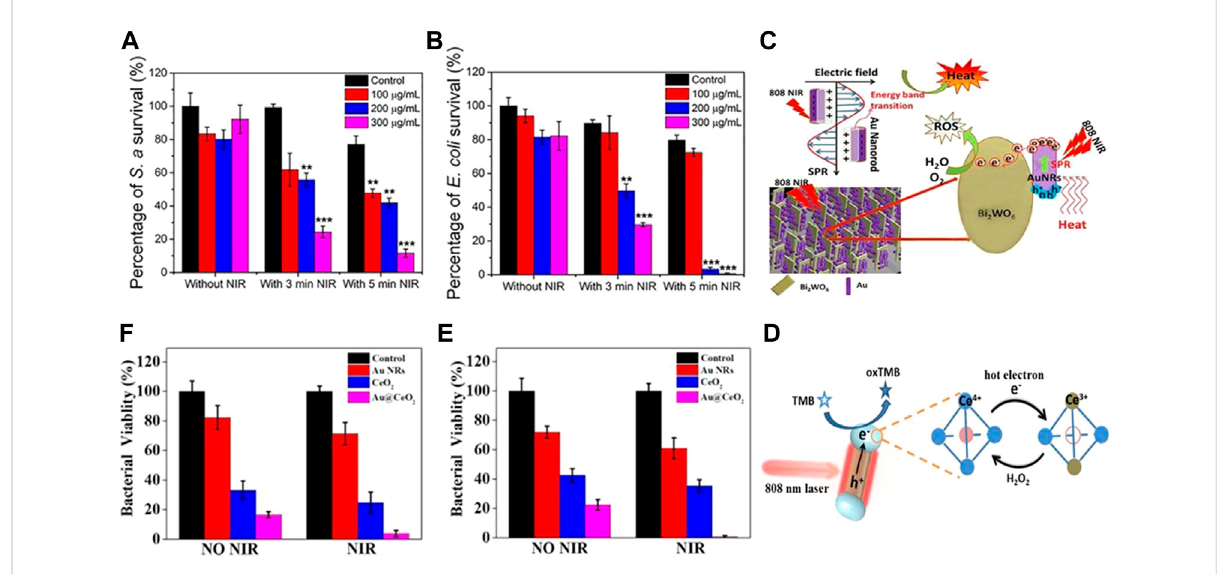
FIGURE 3 (A) Survivalrateof S.aureus incorrespondinggroup( n =3); (B) SurvivalrateofE. coli incorrespondinggroup( n